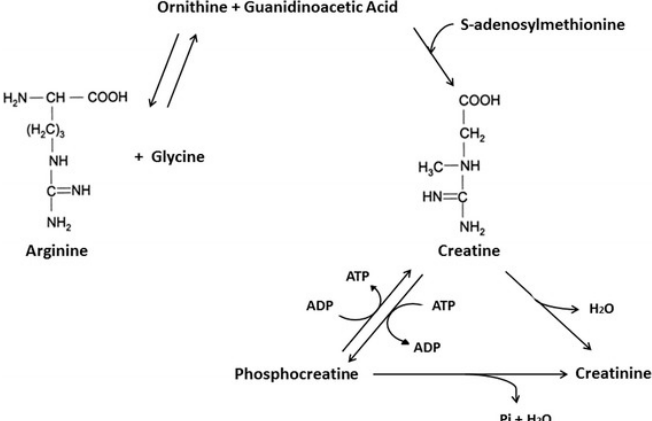
Figure 1. Endogenous creatine synthesis. Adopted from Kreider and Jung [14]. ATP = Adenosine Triphosphate. ADP = Adenosine Diphosphate.